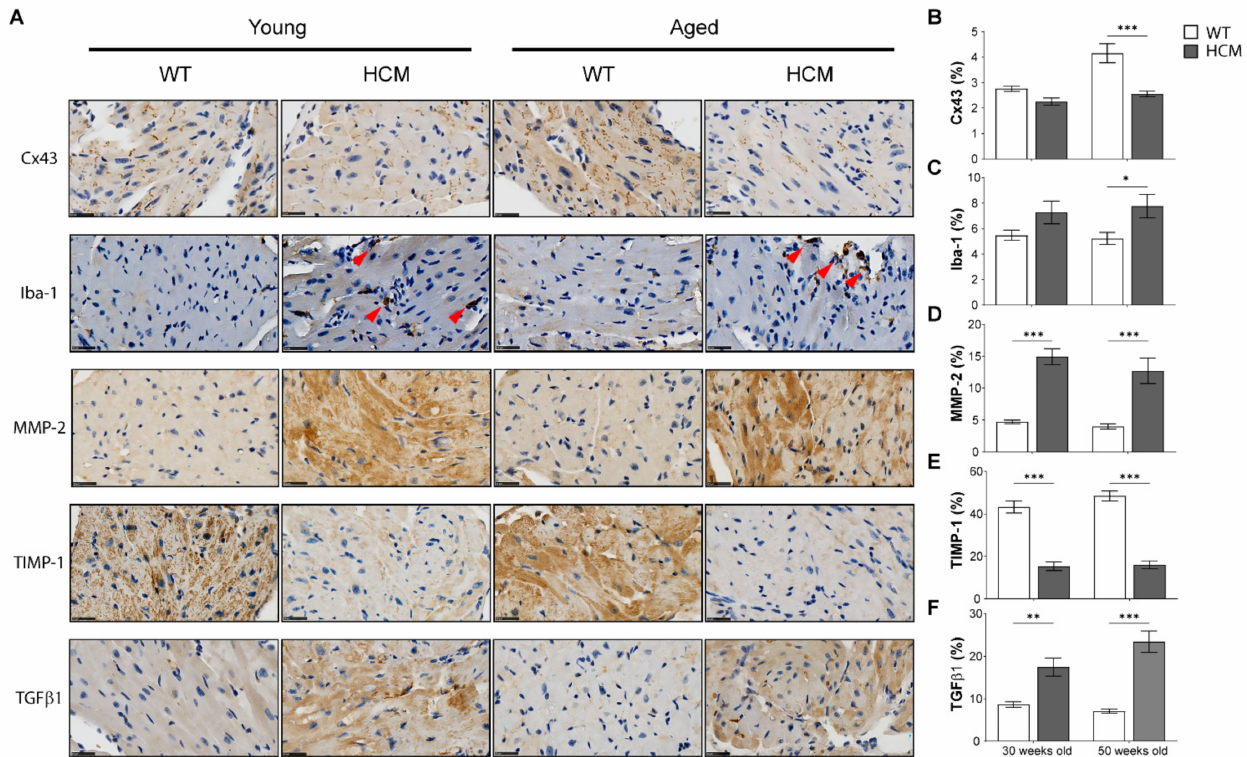
Figure 4. HCM mouse atria demonstrates altered connexin 43 (Cx43) expression, increased macrophage infiltration, and changes in extracellular matrix remodeling. ( A ) Representative photomicrographs of transverse sections of the LA stained for Cx43, ionized calcium binding adaptor molecule 1 (Iba-1) macrophage, matrix metalloproteinase-2 (MMP-2), tissue inhibitor of metalloproteinase 1 (TIMP-1), transforming growth factor beta 1 (TGF β 1) expression. Red arrowheads indicate Iba-1 +ve macrophages. Scale = 25 µ m. Cumulative data on Cx43 ( B ), Iba-1 ( C ), MMP-2 ( D ), TIMP-1 ( E) , and TGF β 1 ( F ) expressed as a percentage of total myocardium area in six independent samples per group. * p < 0.05, ** p < 0.01 and *** p <